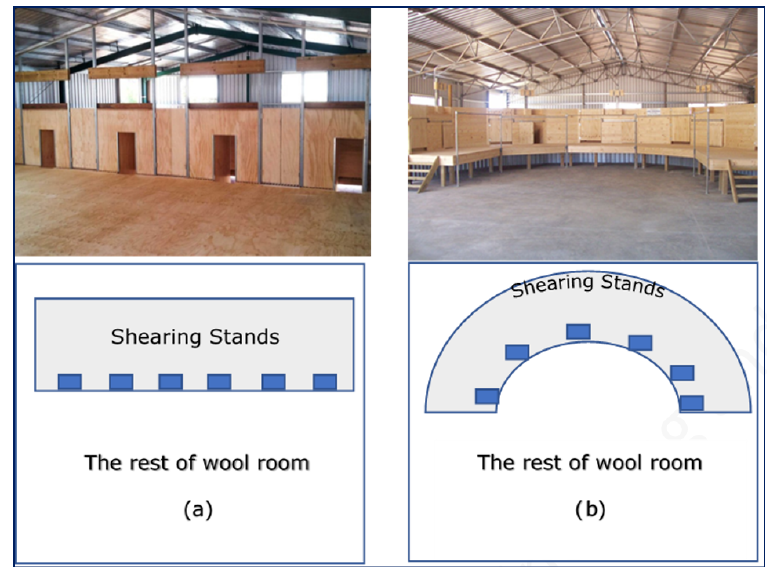
Figure 1. Shearing stands arrangement, (a) Linear layout (Shearing Shed Solutions, n.d.), (b) curved layout (Kendrick Sheds,